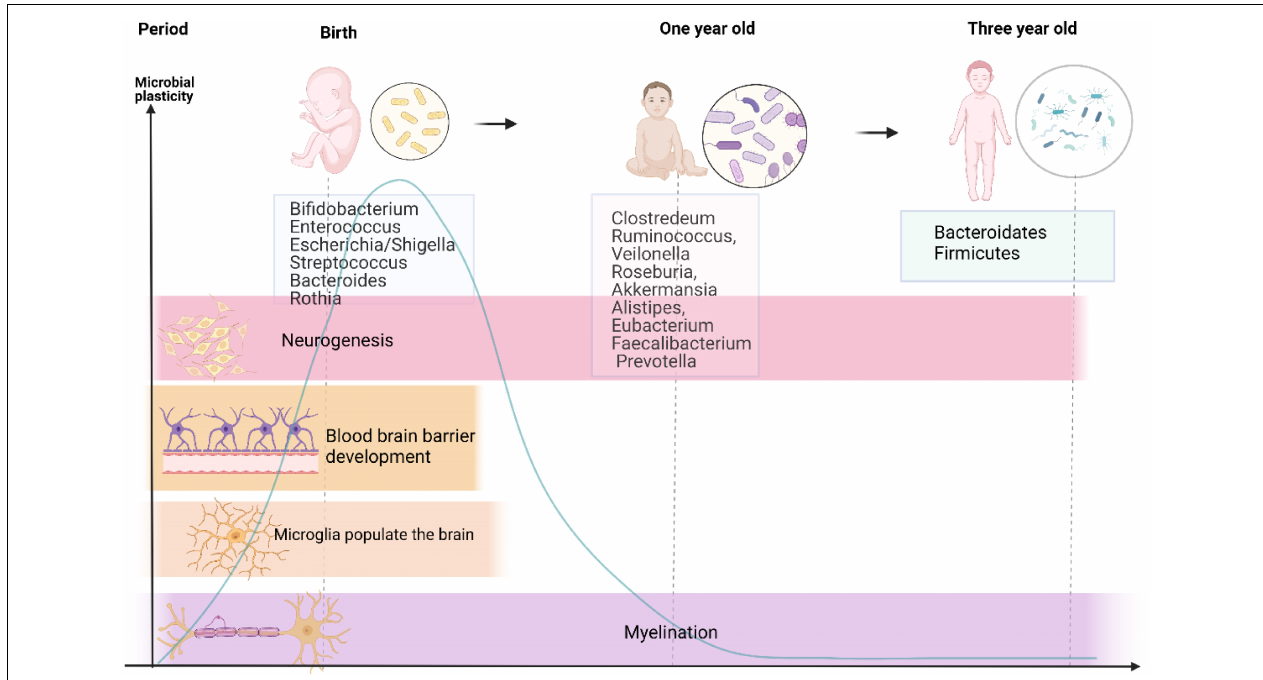
FIGURE 1 | Developmental trajectories of gut microbiome and major neurodevelopmental events from birth to 3-year-old. This graph reveals changes in gut microbiota from birth to 3-year-old accompanied by major processes in neural development, suggesting that the developmental trajectory of the nervous system seems to overlap with that of the intestinal flora as life progresses. There exists a sensitive period in the gut–brain axis development, which is present with high microbial plasticity and critical for neurodevelopment. Microbial taxa in the middle are the predominant ones at different stages of